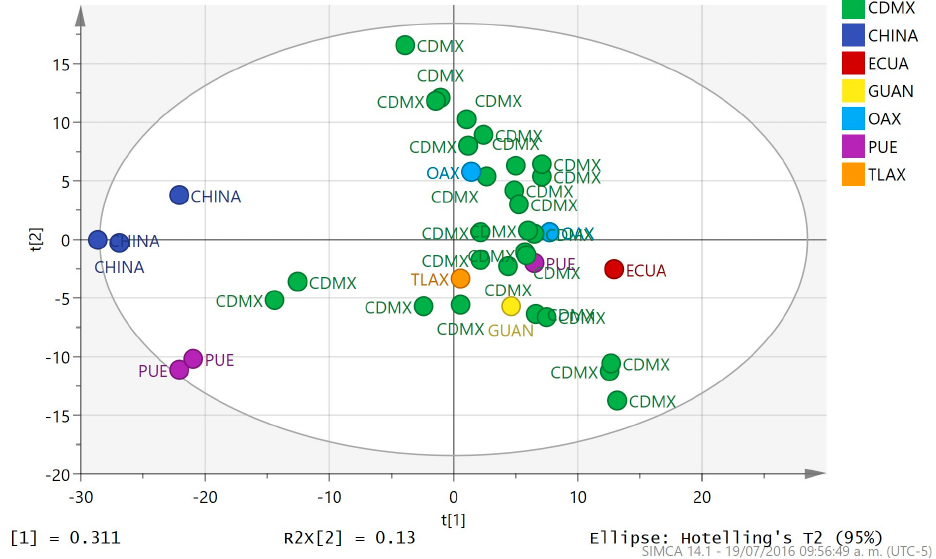
Figure 2. t2 vs. t1 score plot for PCA analysis of 1 H-NMR spectra of propolis samples labeled according to their origin: Mexico City (CDMX), Puebla (PUE), Oaxaca (OAX), Guanajuato (GUAN), Tlaxcala (TLAX), Ecuador (ECUA) and China (CHINA).